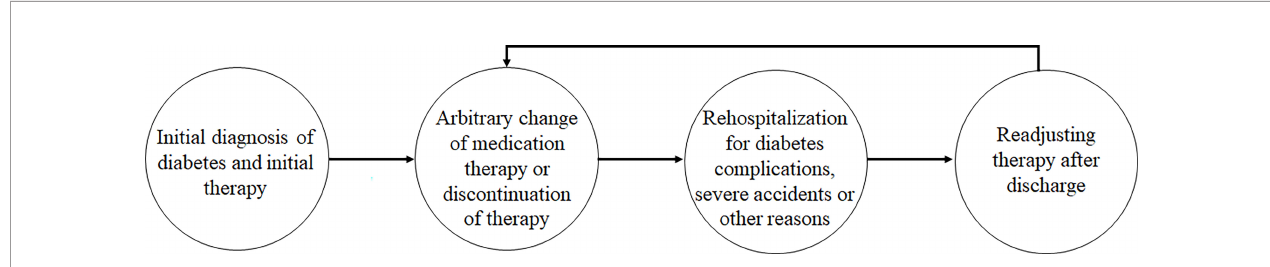
FIGURE 1 | The vicious cycle of medication management of patients with a relatively long duration of type 2